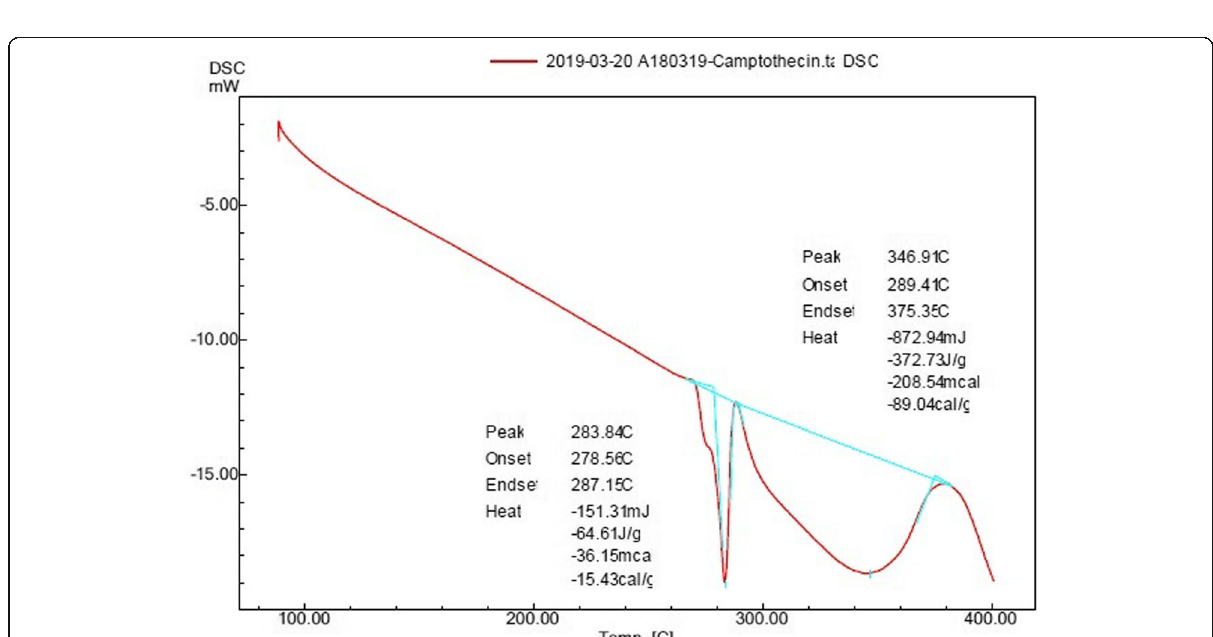
Fig. 2 DSC spectra of camptothecin